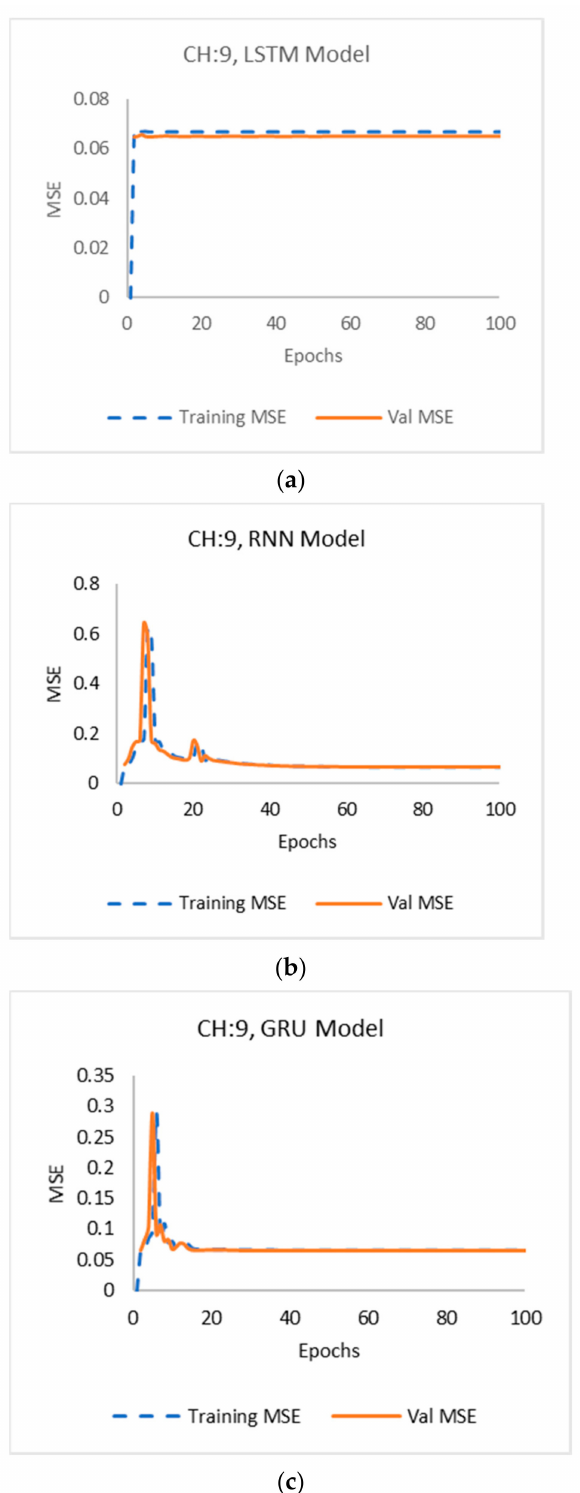
Figure 29. Channel 9: Training and validation error using ( a ) LSTM, ( b ) RNN and ( c ) GRU models. It was observed that the LSTM has the least error and requires the least number of epochs to reach a steady state. Figure 30 compares the original and predicted BCI signal at channel 2 as a sample based on unknown FBG data. Figure 31 provides a close-up at two instances to clearly show the resemblance between the original and the predicted